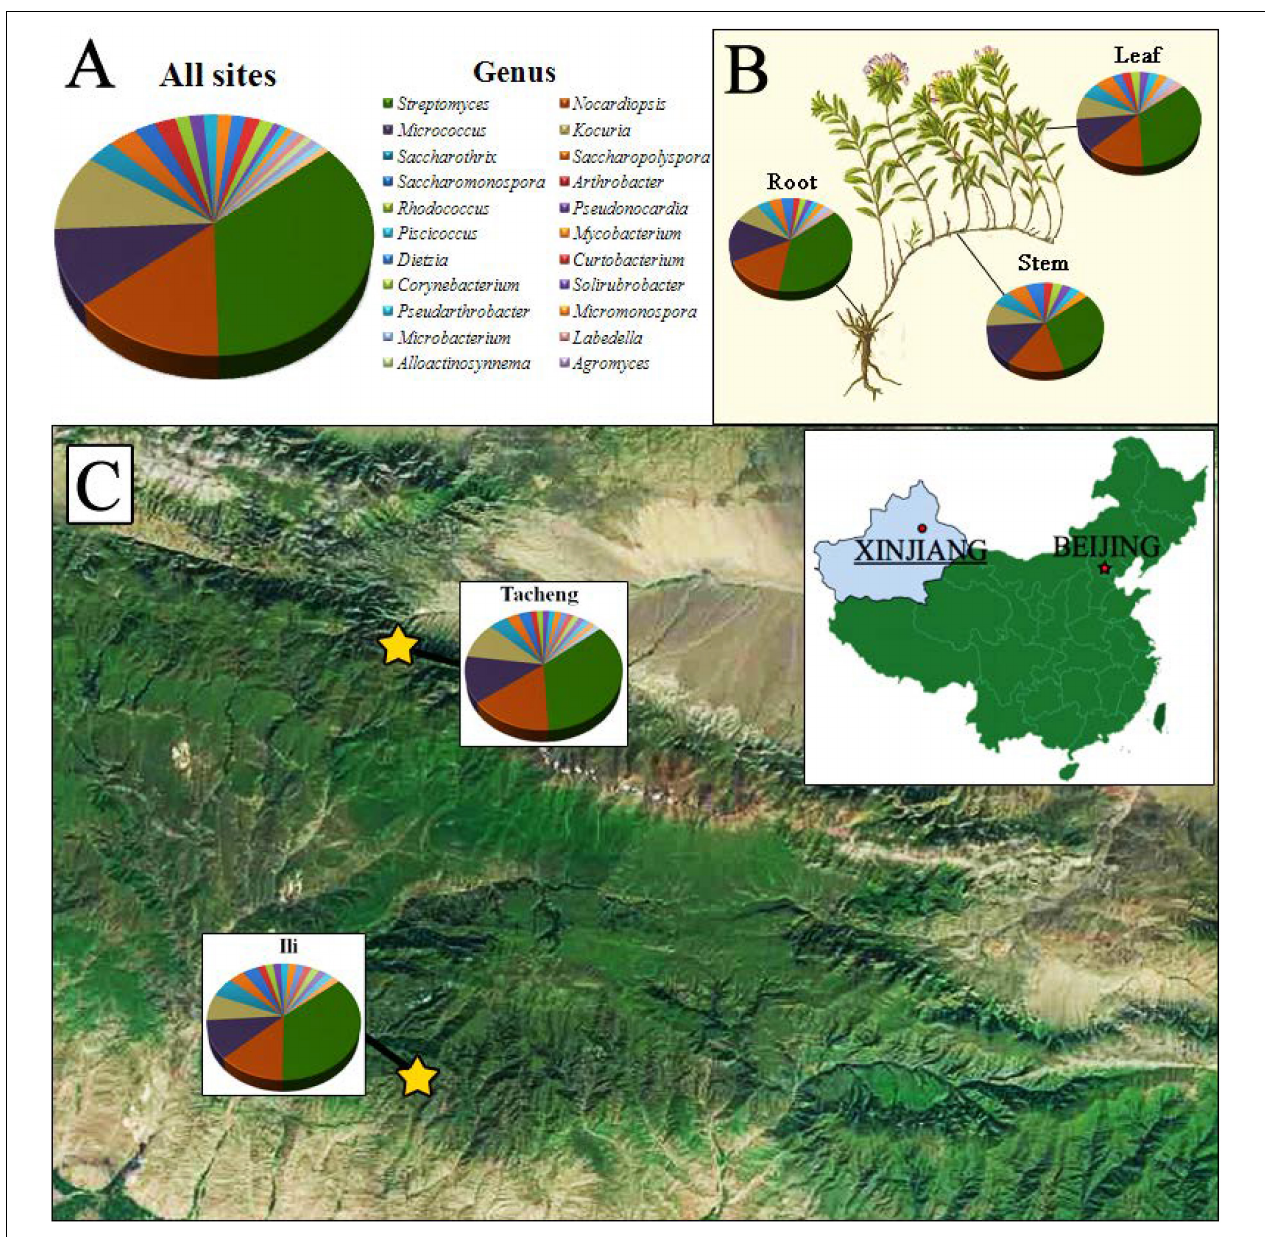
FIGURE 1 | The distribution and identity of 126 culturable endophytic actinomycetes from T. roseus Schipcz. based on 16S rRNA gene sequences. (A) A summary of genera present at all sites. (B) Genus assignments for isolates from different tissues. (C) Genus assignments according to location and showing the high diversity of isolates from the most arid site,